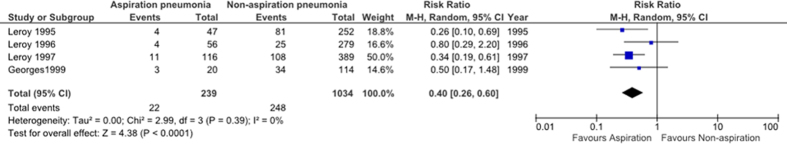
Pooled mean difference for ICU mortality with 95% confidence intervals for eligible studies.